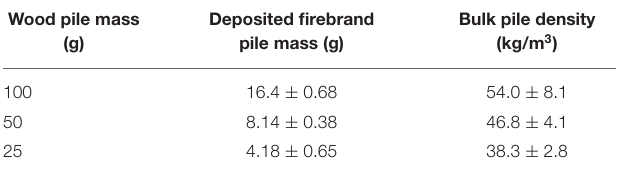
TABLE 1 | Firebrand loading conditions for three pile sizes used in inert and ignition tests. Wood pile mass